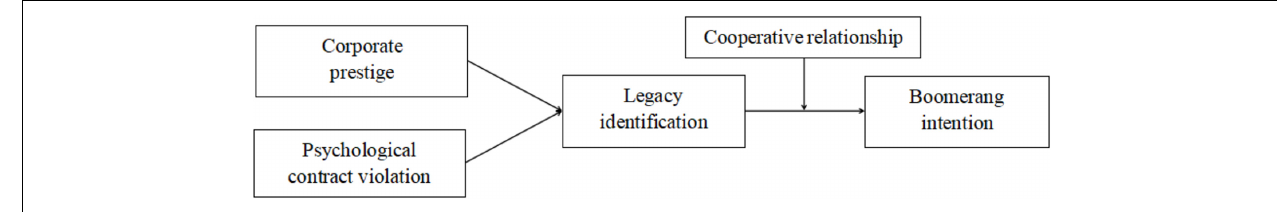
FIGURE 1 | Hypothesized research